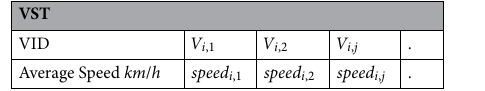
Table 5. Average speed of the